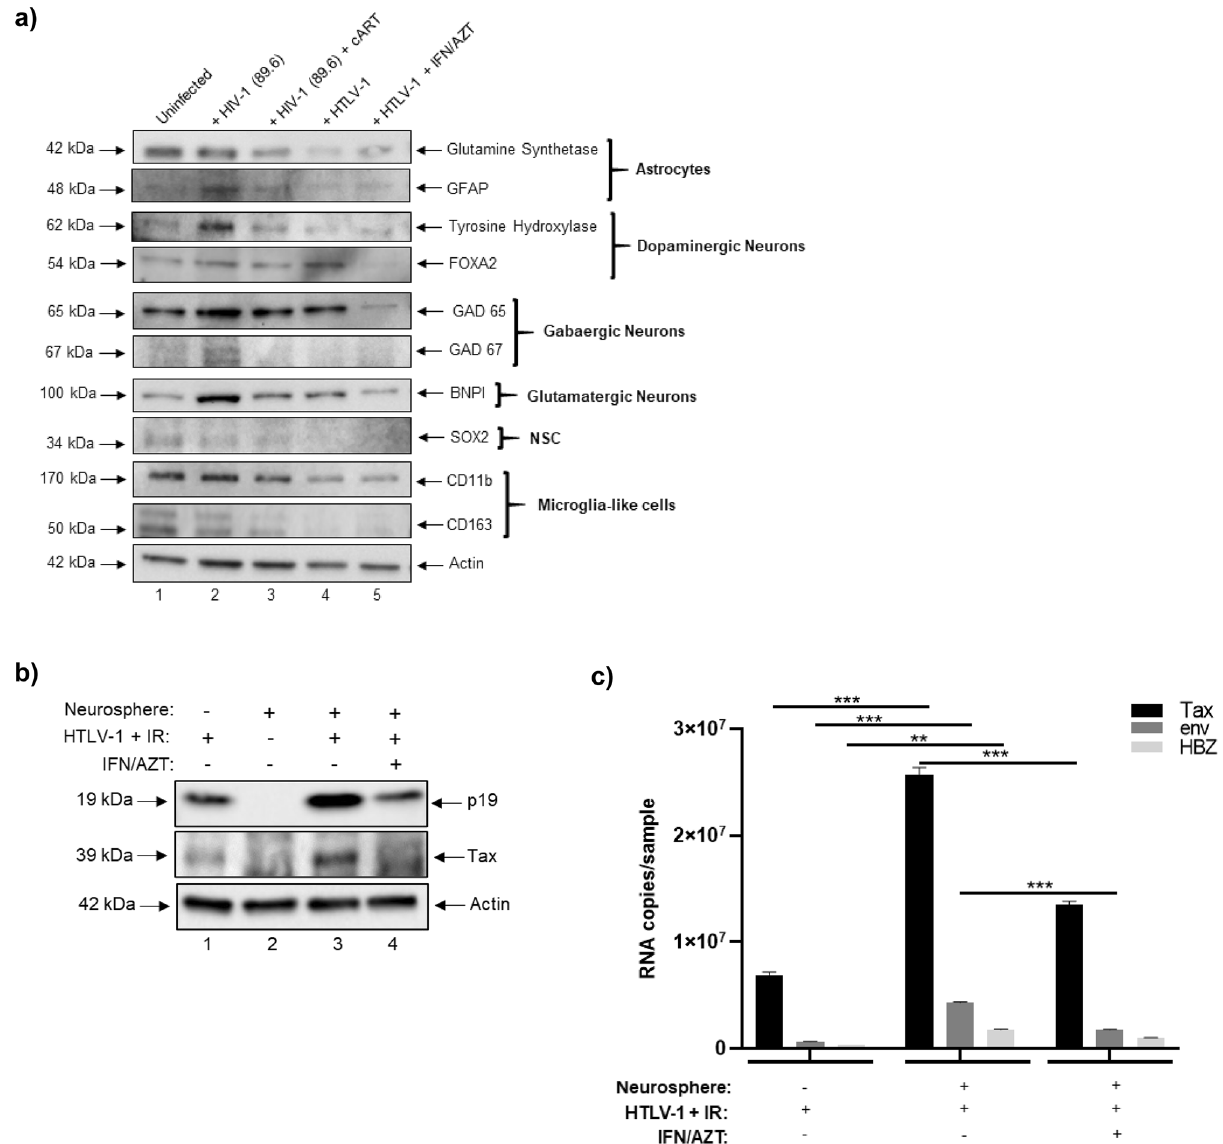
Figure 3. HTLV-1 co-culture and expression of cellular markers in HIV-1 and HTLV-1 infected neurospheres. (a) Differentiated neurospheres were exposed to dual-tropic HIV-1 89.6 with or without cART (lamivudine, tenofovir disoproxil fumarate, emtricitabine, indinavir), or were co-cultured with irradiated HTLV-1 infected cells with or without IFN/AZT for a period of fourteen days. Western blot was performed to examine